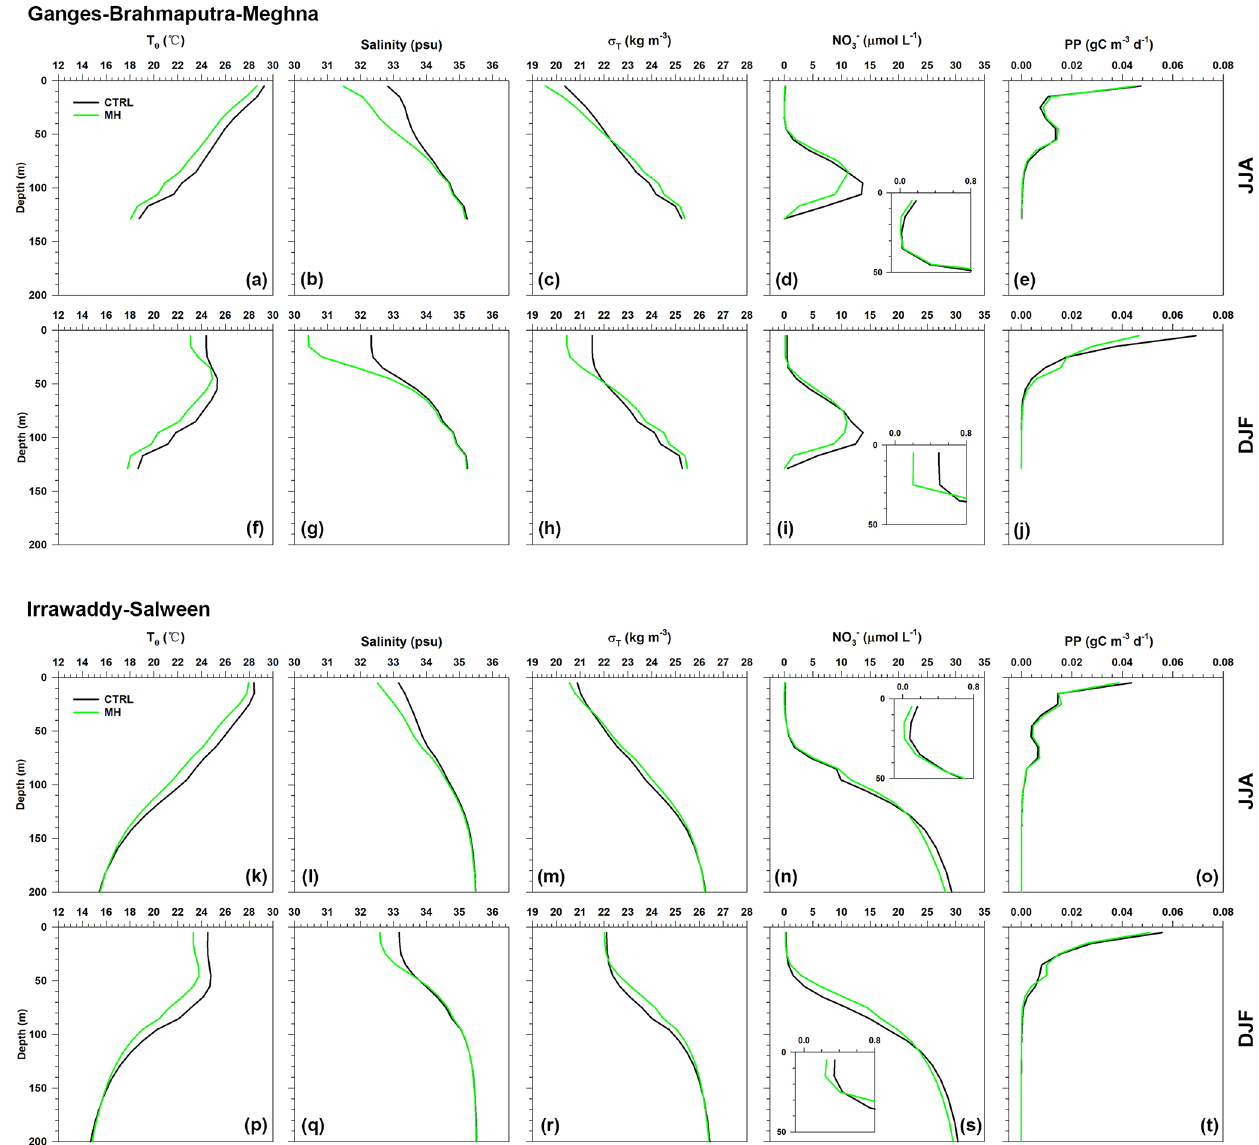
Figure 4. Simulated ocean profiles between 0 and 200 water depths in the MH and CTRL simulations run with IPSL-CM5A-LR. Data in panels (a) – (j) have been extracted from the grids located in the Ganges–Brahmaputra–Meghna river mouth (rectangle 1 in Fig. 3d). (a–e) Results for summer (June–July–August, JJA). (f–j) Results for winter (December–January–February, DJF). Data in panels (k) – (t) have been extracted from the grids located in the Irrawaddy–Salween river mouth (rectangle 2 in Fig. 3d). (k–o) Results for summer (JJA). (p–t) Results for winter (DJF). The parameters shown here are potential temperature ( T θ ), salinity, potential density (sigma- t , σ T ), nitrate concentration of seawater representing seawater nutrient content (NO − ), and total primary productivity (PP). The nutricline, halocline, and 3 pycnocline are the depths with the largest vertical gradients of nutrient content, potential density, and salinity under the upper seawater